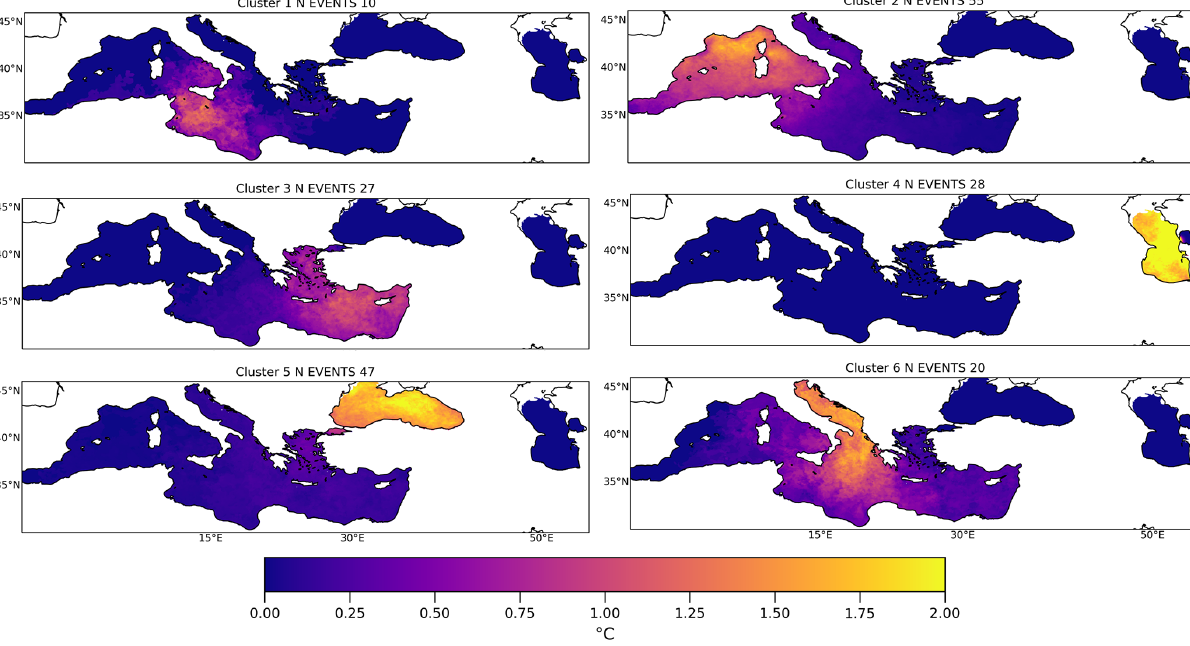
grid point of the ESA CCI SST dataset, and then, using